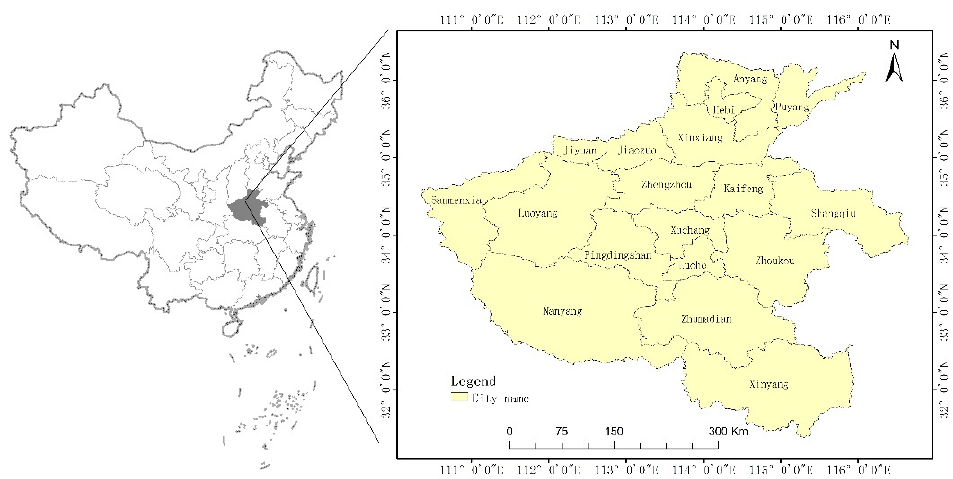
Figure 1. Study area—Henan, China.